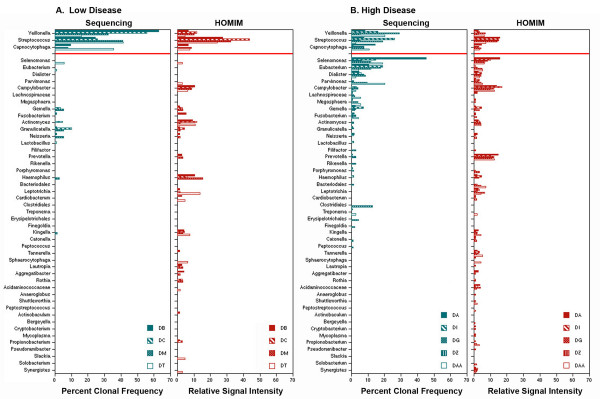
Comparison of 16S rRNA gene analyses using sequencing and HOMIM. The frequency of bacterial types (by percentage), determined by 16S rRNA sequencing, of 4 plaque samples from low disease and 5 plaque samples from high disease West Virginians, ranked based on criteria defined in Materials and Methods, was compared with the microarray signal intensity obtained from the same samples in HOMIM analyses. Bacterial types above the red line were more frequent in low disease.